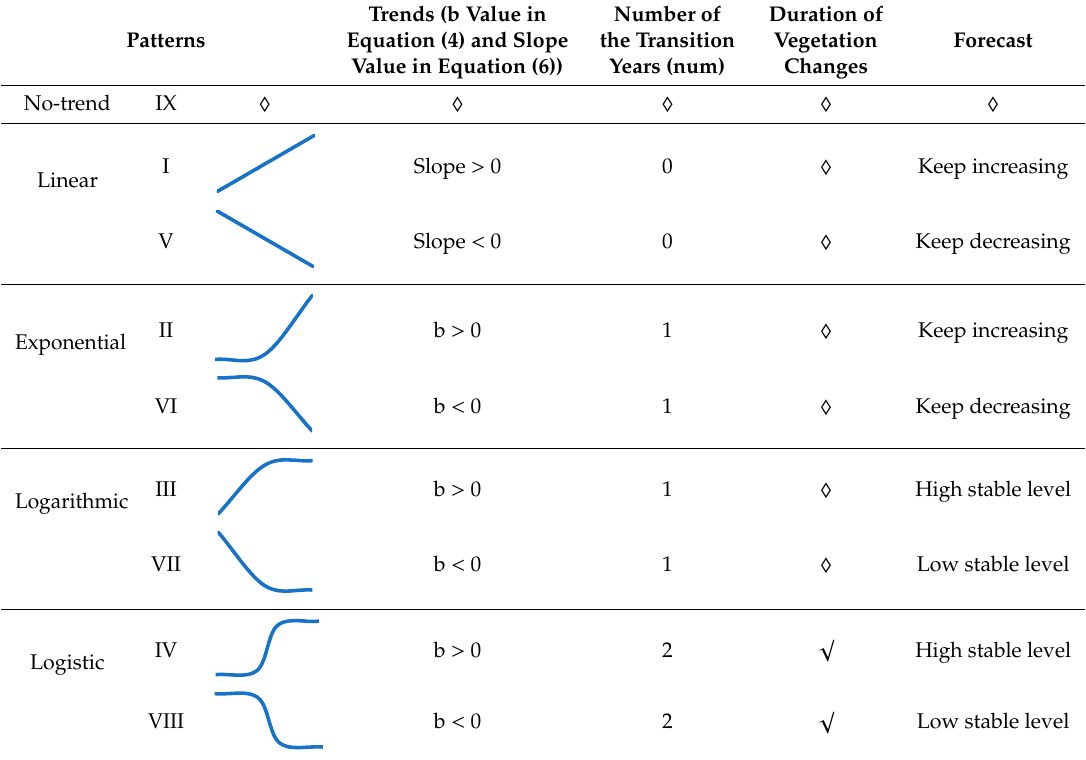
Table 1. Patterns of vegetation gradual changes are discussed in our study. Features of each pattern, including trend, transition years, duration and forecast of vegetation change are shown below. Options with the symbol ◊ will be excluded for discussion in our study, while the others will be considered for analyses in the study.